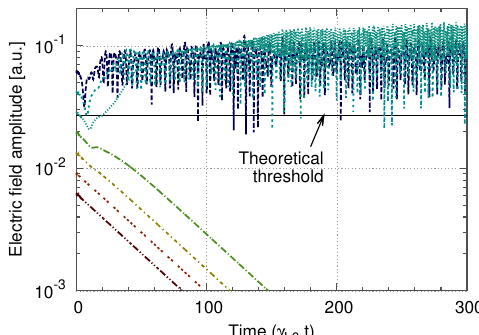
Figure 11. Dashed curves: time-series of electric field amplitude for different initial amplitudes in a subcritical case (the dissipation/drive ratio is γ d / γ L = 1.05). Solid line: theoretical nonlinear instability threshold